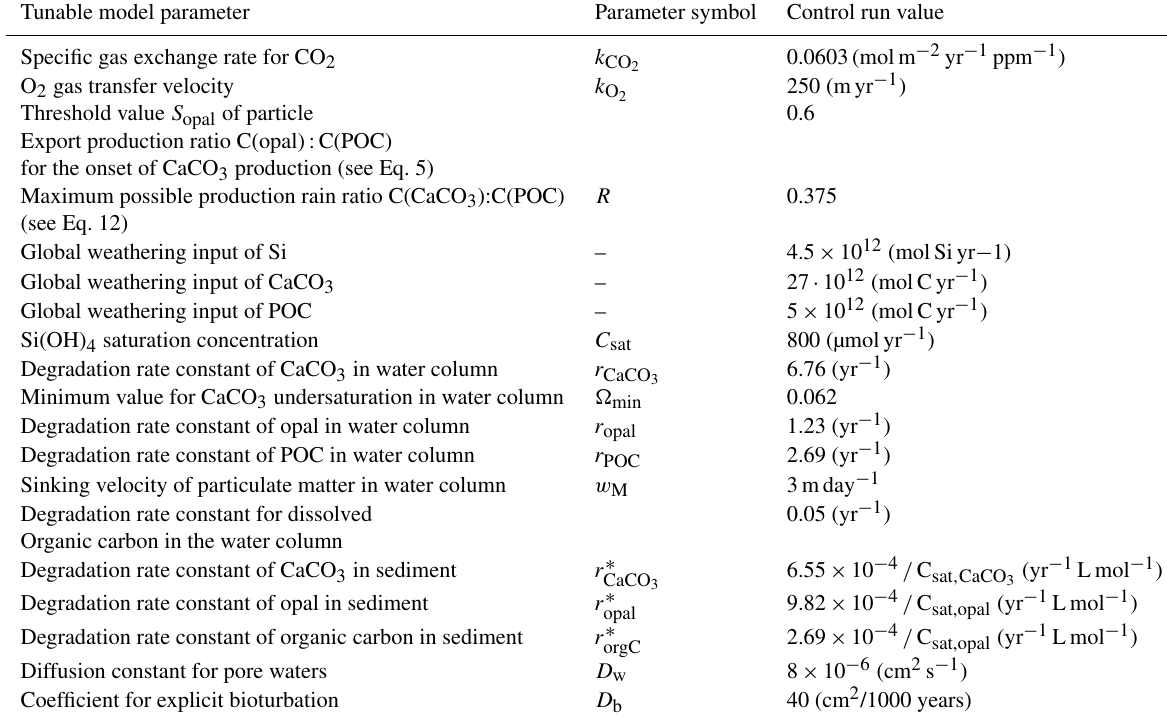
Table A1. Model parameter values as set for the control or standard run. Tunable model